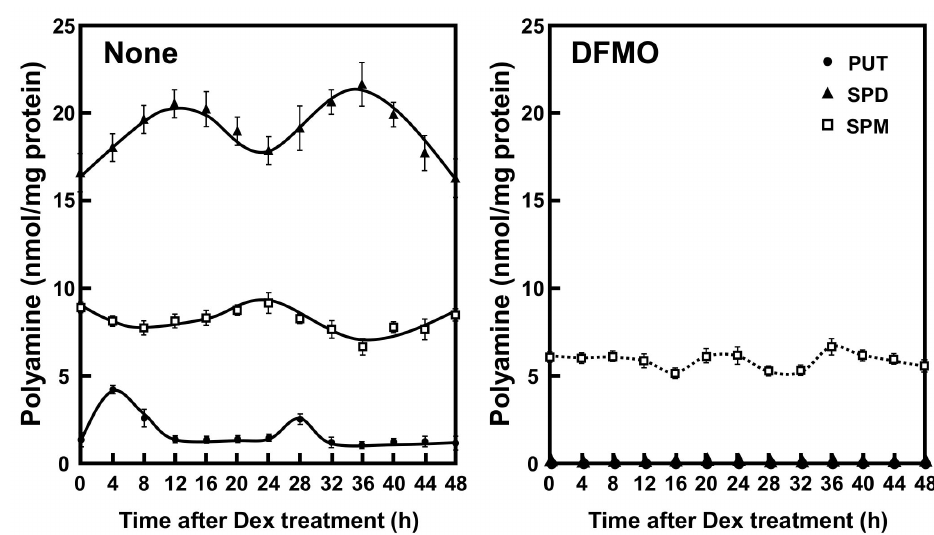
Figure 1. Temporal content profiles of intracellular polyamines in mouse fibroblast NIH3T3 cells. NIH3T3 cells were synchronized by dexamethasone (Dex) and harvested at 4 h intervals throughout a period of 48 h in the presence and absence of α -difluoromethylornithine (DFMO). The levels of intracellular polyamines were measured by HPLC as described in the Materials and Methods